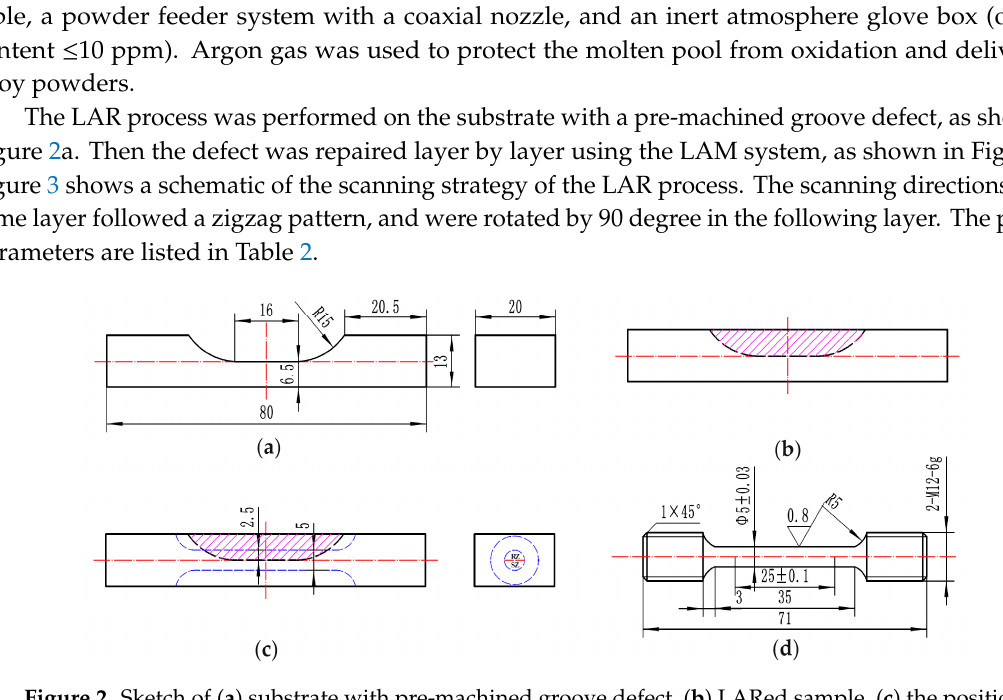
Figure 2. Sketch of ( a ) substrate with pre-machined groove defect, ( b ) LARed sample, ( c ) the position of the tensile testing bar in the LARed sample, and ( d ) shape and size of the tensile testing bar.